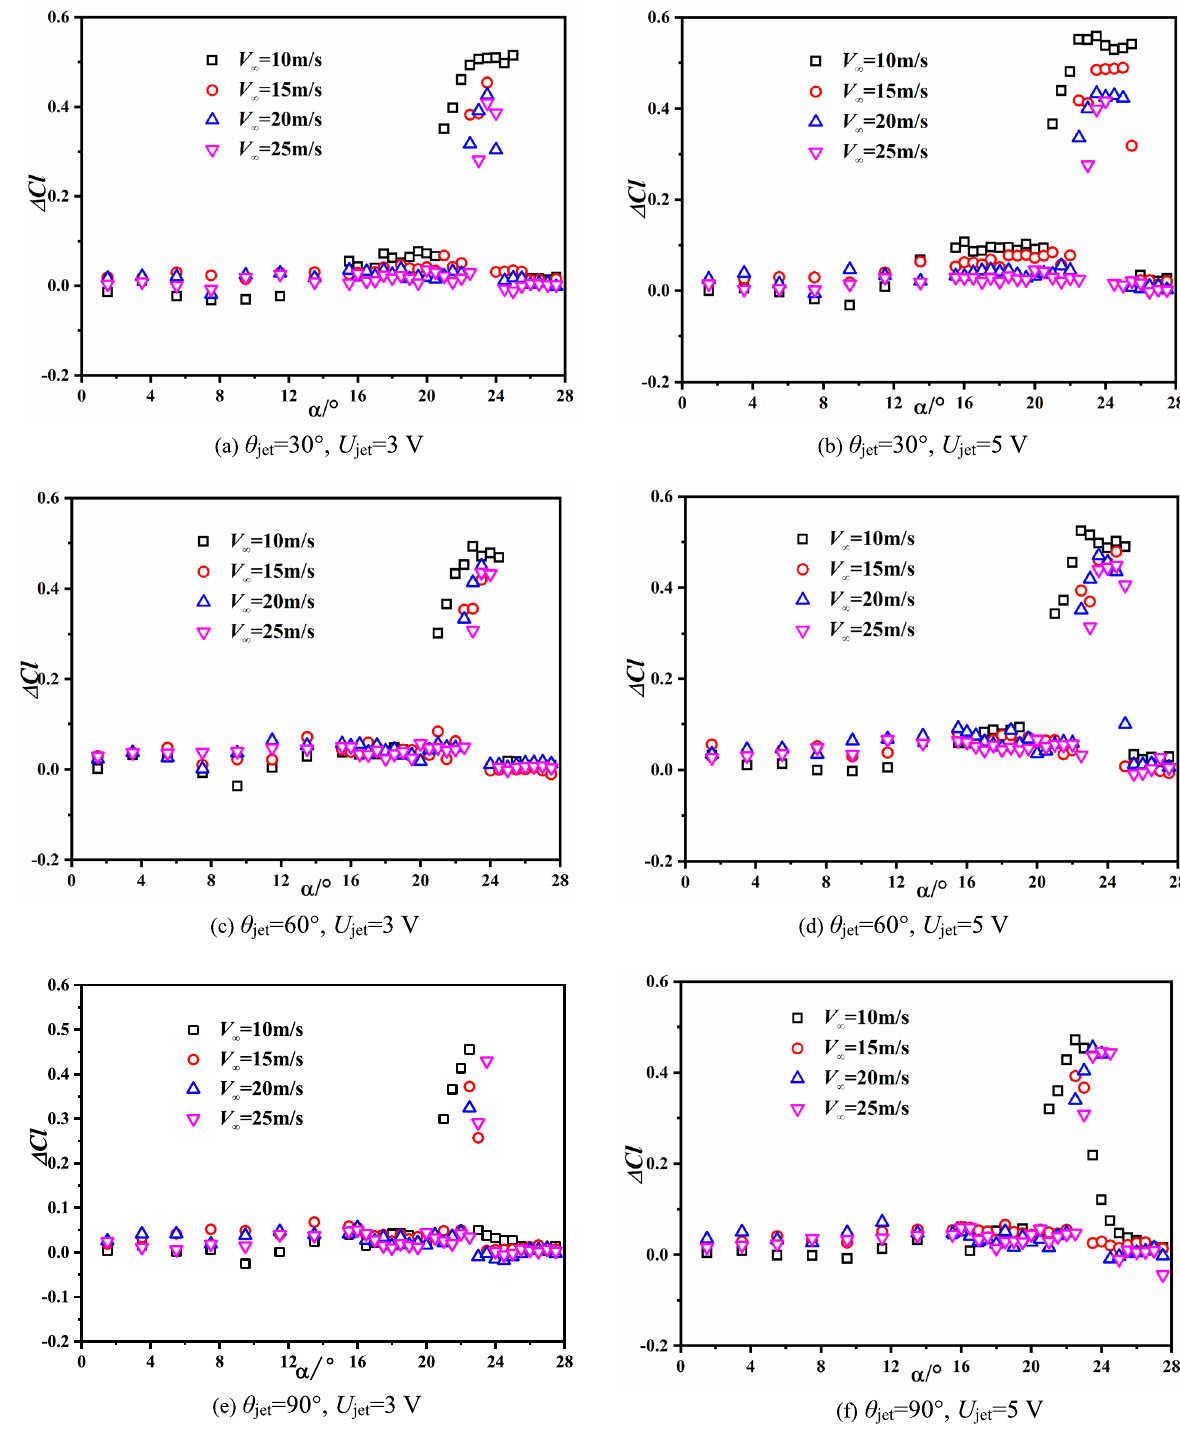
Figure 16. Variations of lift coefficient with different momentum